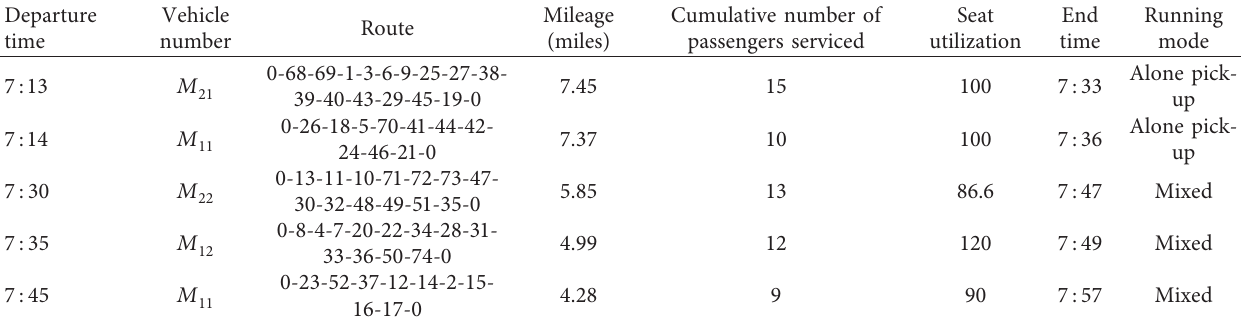
Table 7: Optimization results under mixed running mode in the initial service area.